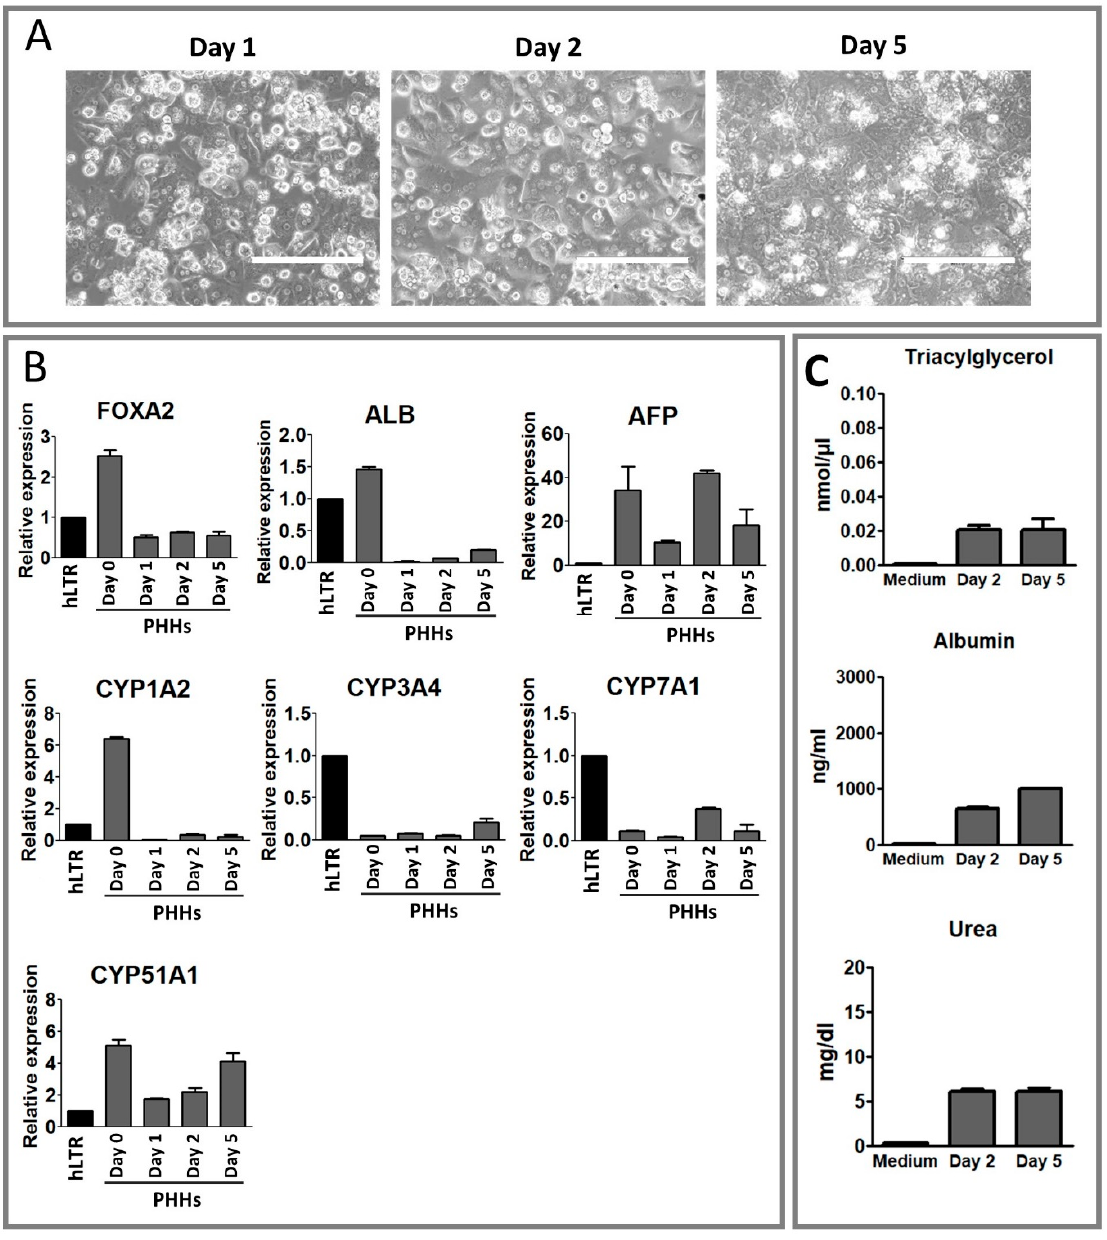
Figure 1. Evaluation of the morphology and functionality of primary human hepatocytes (PHHs) during the course of dedifferentiation. ( A ) Phase contrast images showing the morphology of the PHHs at days 1, 2, and 5 of the culture. The scale bar represents 200 µm. ( B ) qPCR analysis of FOXA2 , ALB , AFP , CYP1A2 , CYP3A4 , CYP7A1 and CYP51A1 genes at days 0, 1, 2, and 5. The gene expression data for FOXA2 , ALB , and AFP was normalized to housekeeping gene, GAPDH , and CYP genes were normalized to both GAPDH and B2M. The values are presented relative to the human liver total RNA (hLTR) sample. Each sample was run in technical triplicate and bars represent mean ± SD of three biological replicates. ( C ) Biochemical analysis of the conditioned media of the PHHs for secreted triacylglycerol (TAG), albumin, and urea at day 2 and 5 of the culture. Values are presented per well, per 24 h. Bars represent mean ± SD of at least three biological replicates.